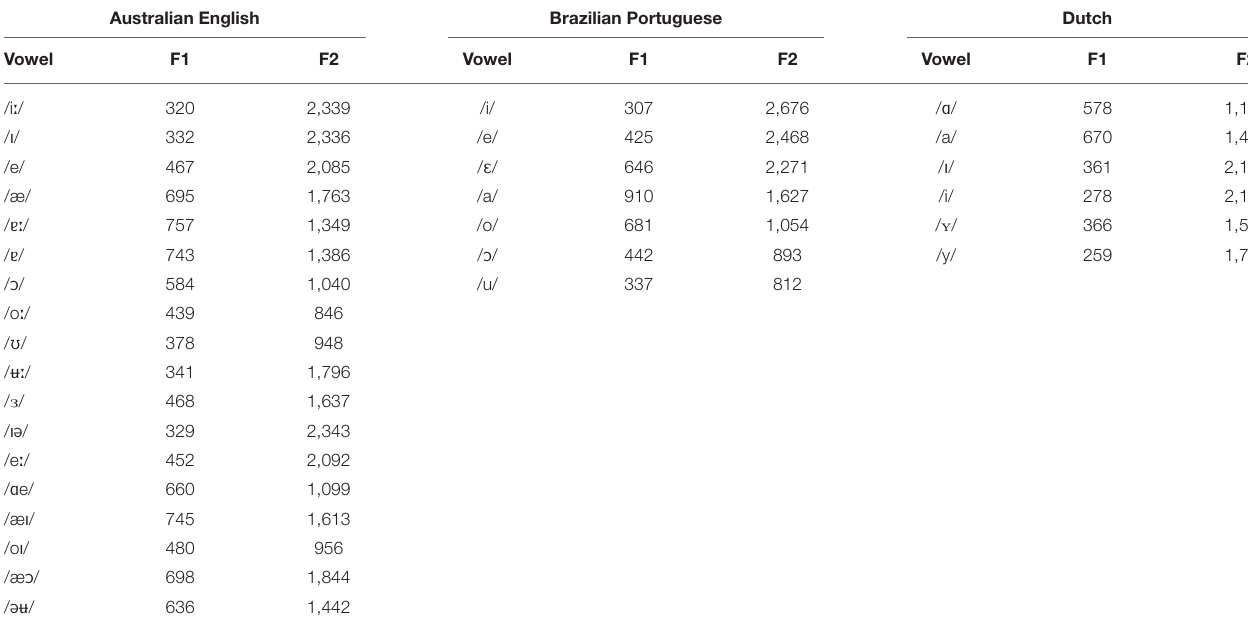
TABLE 1 | Formant values (Hz) of vowels across languages used in present study. Australian English Brazilian Portuguese Dutch